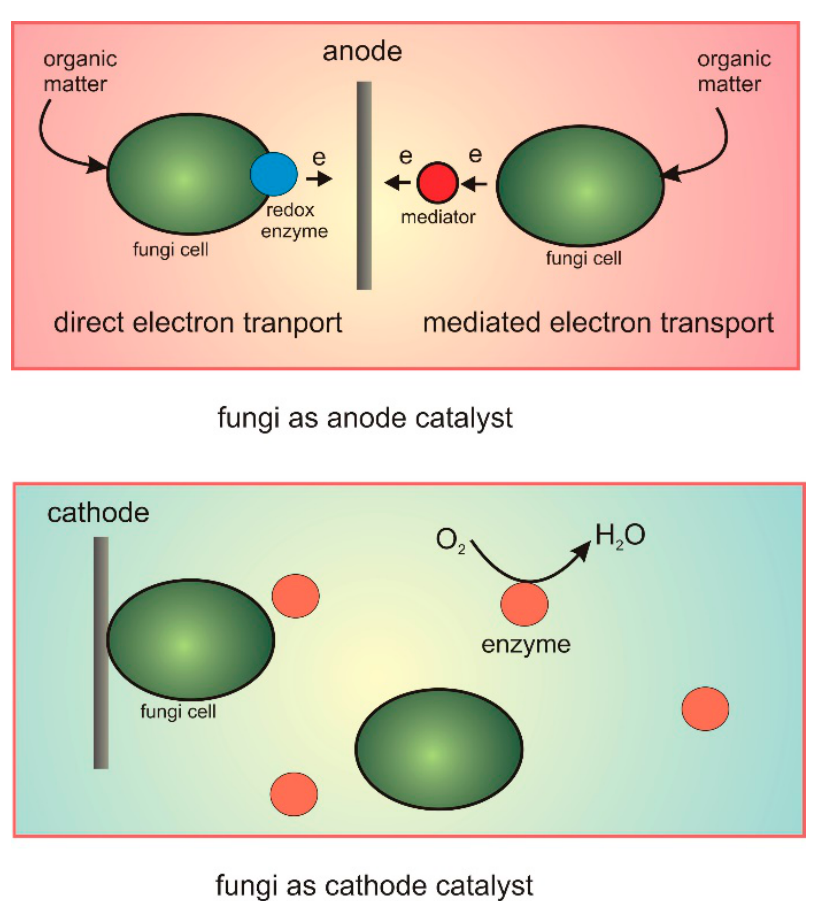
Figure 1. Application of fungi in microbial fuel cells (MFCs): As an anode catalyst (with direct or mediated electron transfer to the anode) or as a cathode catalyst (fungi are the producer of enzymes catalyzing the reduction of oxygen).